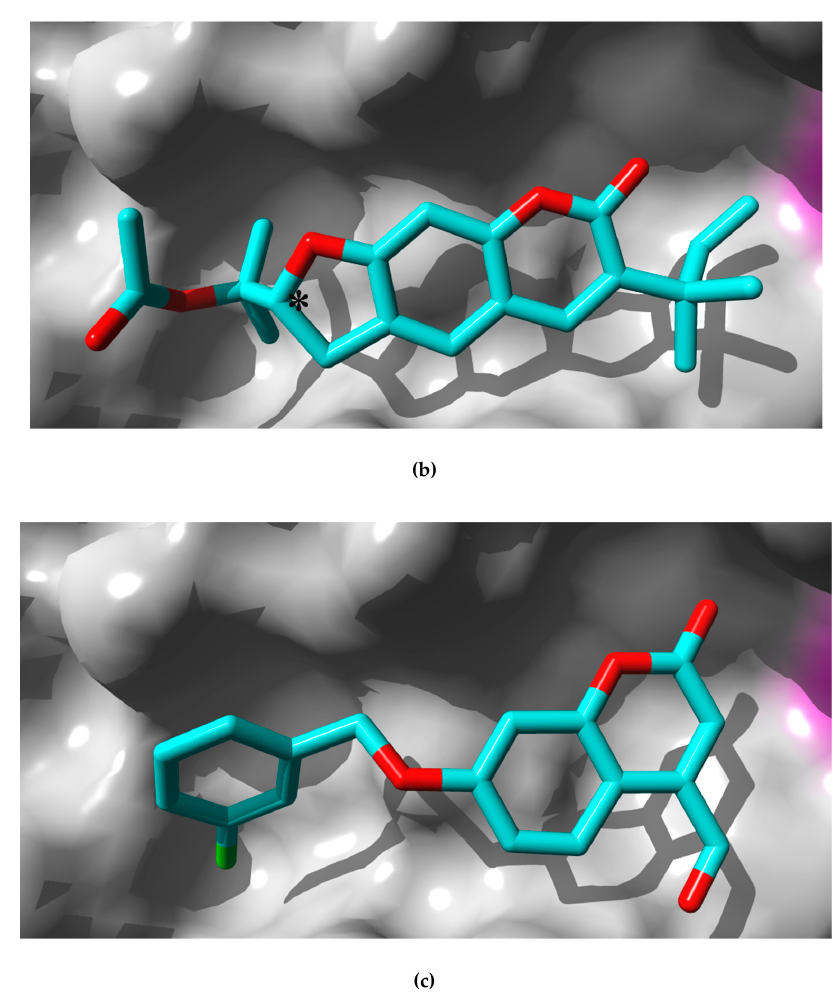
Figure 3. Comparison of docking orientation of ( S )-rutamarin molecule ( a ) and ( R )-rutamarin molecule ( b ) with 7-(3-chlorobenzyloxy)-4-carboxaldehyde–coumarin, the template co-crystalized with the binding site of the target structure ( c ). Molecules in atom color code stick mode are depicted on the surface of the binding site (gray); the FAD cofactor as a part of the catalytic center is located on the right hand side of each figure (magenta surface); asterisk denotes the carbon atom that makes the center of chirality in rutamarin structure. In ( a ), atoms of the Y326 and key hydrogen bond with ( S )-rutamarin molecule (green arrow) are shown.